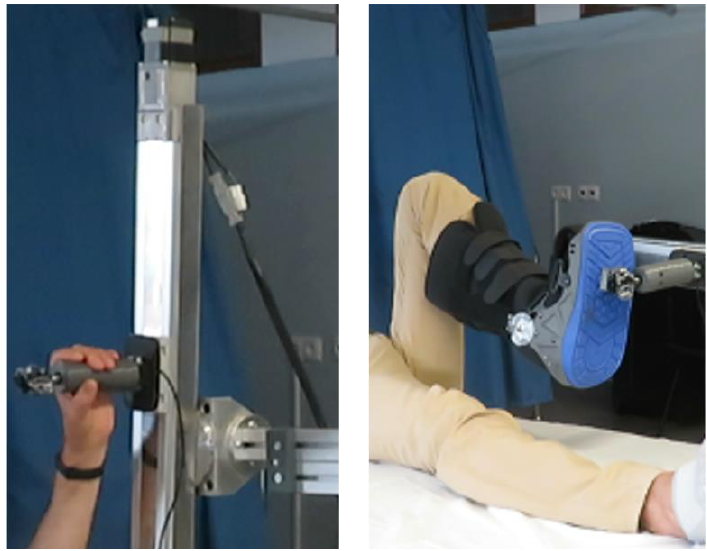
Figure 2. Ablefit handle for upper limbs ( left ) and Ablefit boot for lower limbs (right).